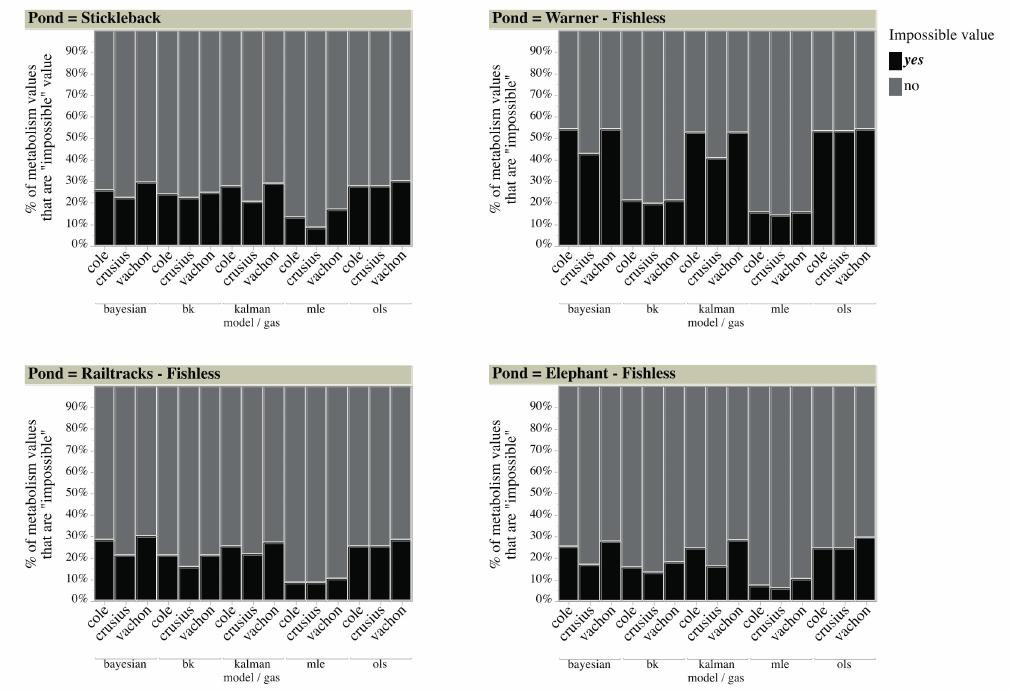
Figure 9. Percentage of ecosystem metabolism values that were impossible (GPP < 0 or R > 0) for a variety of models and reaeration coe ffi cients from Winslow et al. [43] for four ponds from east-central Minnesota,